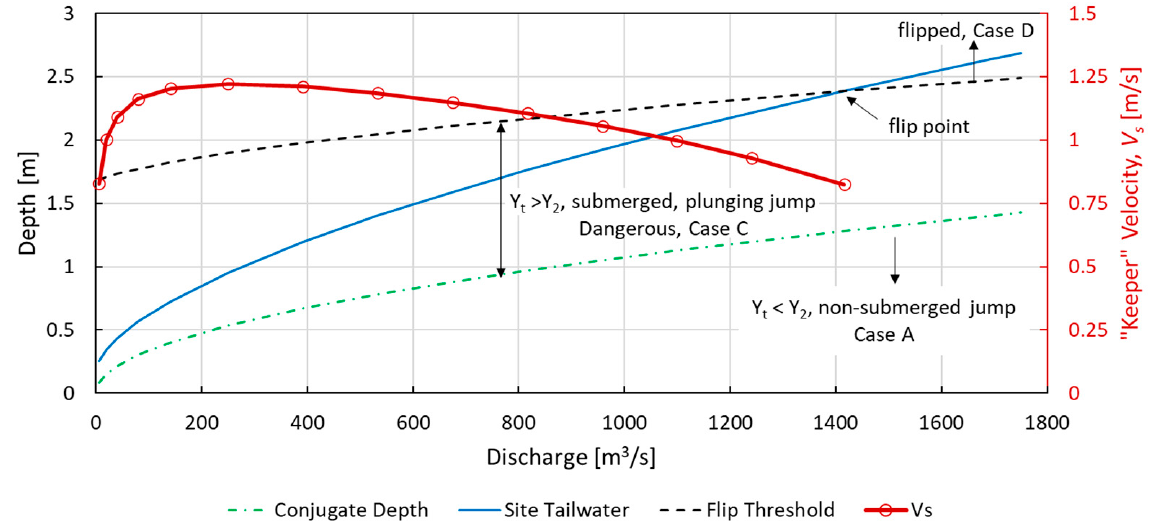
Figure 7. Predicted submerged hydraulic jump conditions at Dock Street Dam.